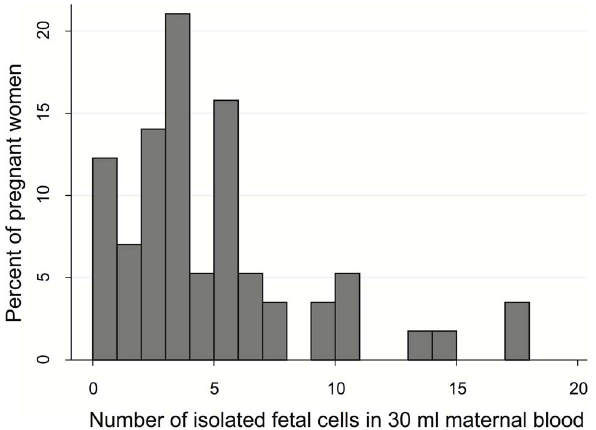
Figure 1. Distribution of the number of isolated fetal cells in 30 ml blood in 57 pregnant women at a gestational age of 11– 14 weeks.